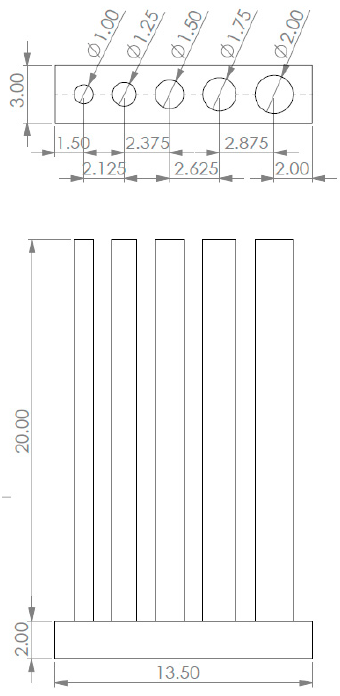
Figure 1. Technical drawing of the sample geometry to determine minimum bar thicknesses in relation to orientation and tilting angle.